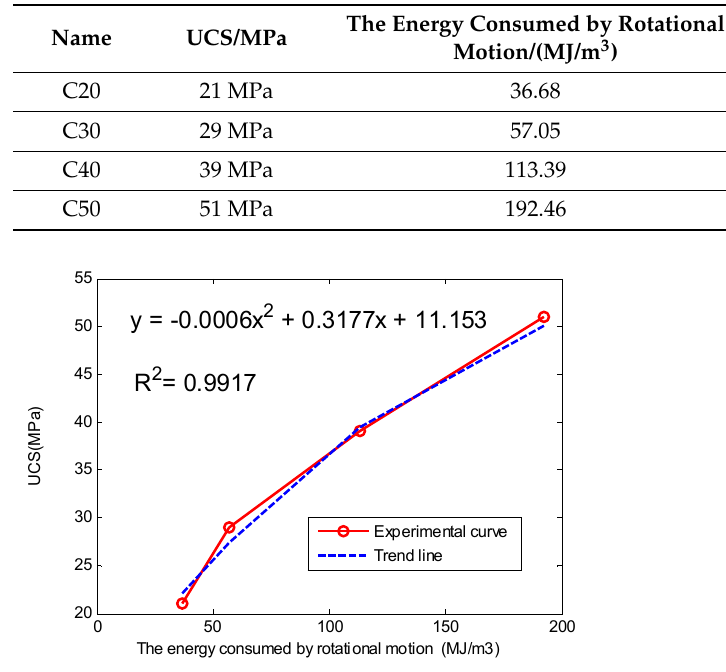
Table 4. Comparison of specific fragmentation work of rocks and the uniaxial compressive strength of the experimental rock.